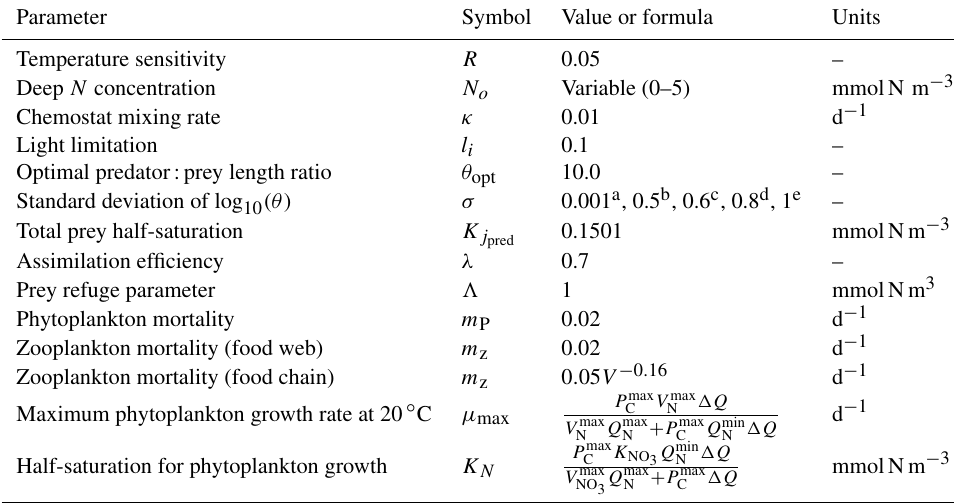
Table 1. Model parameters (Ward et al., 2014 and references with in). Parameter